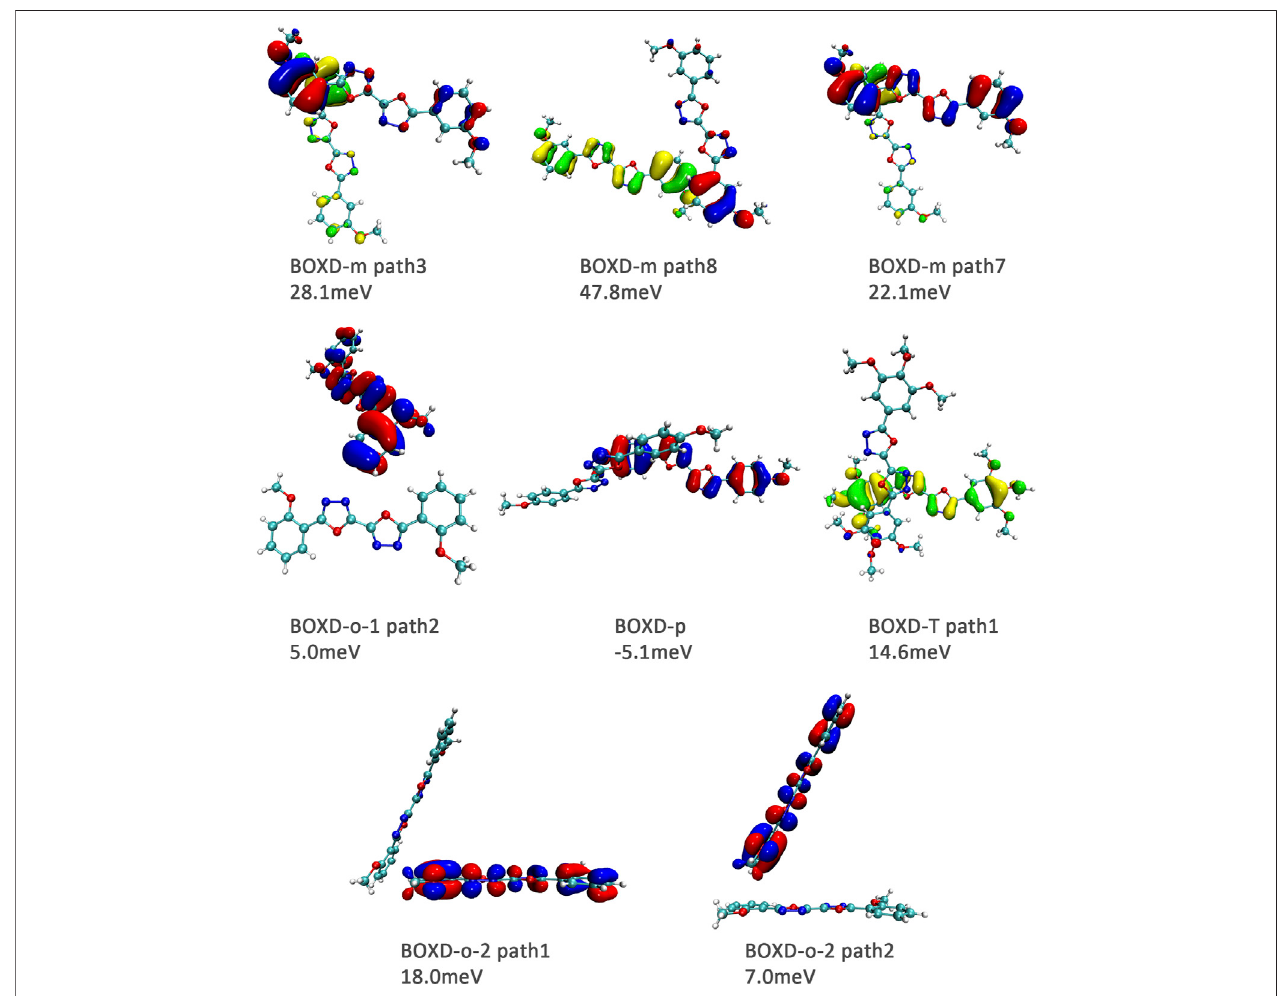
FIGURE 12 | Bimolecular orbital distribution of primary hole transfer paths in herringbone arrangement. The positive phase is depicted in red and yellow, and the negative phase is depicted in blue and green.